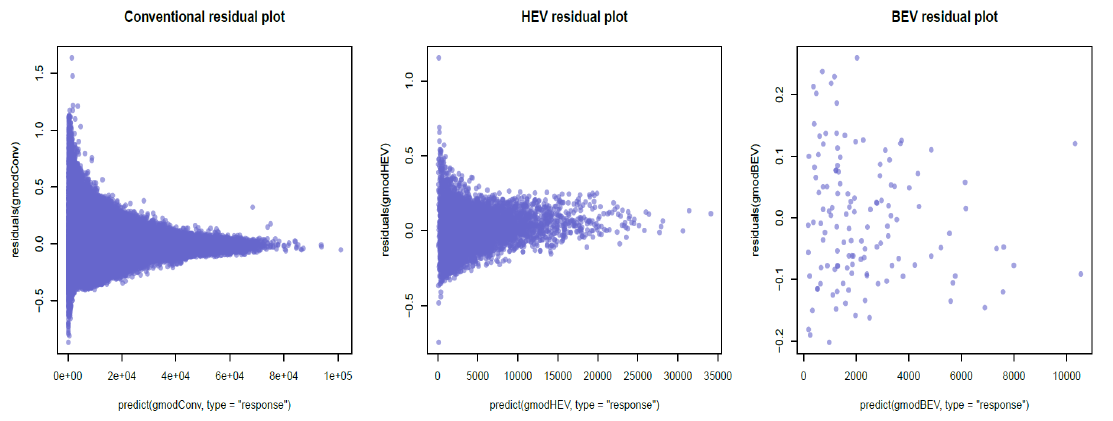
Figure 12. Residual